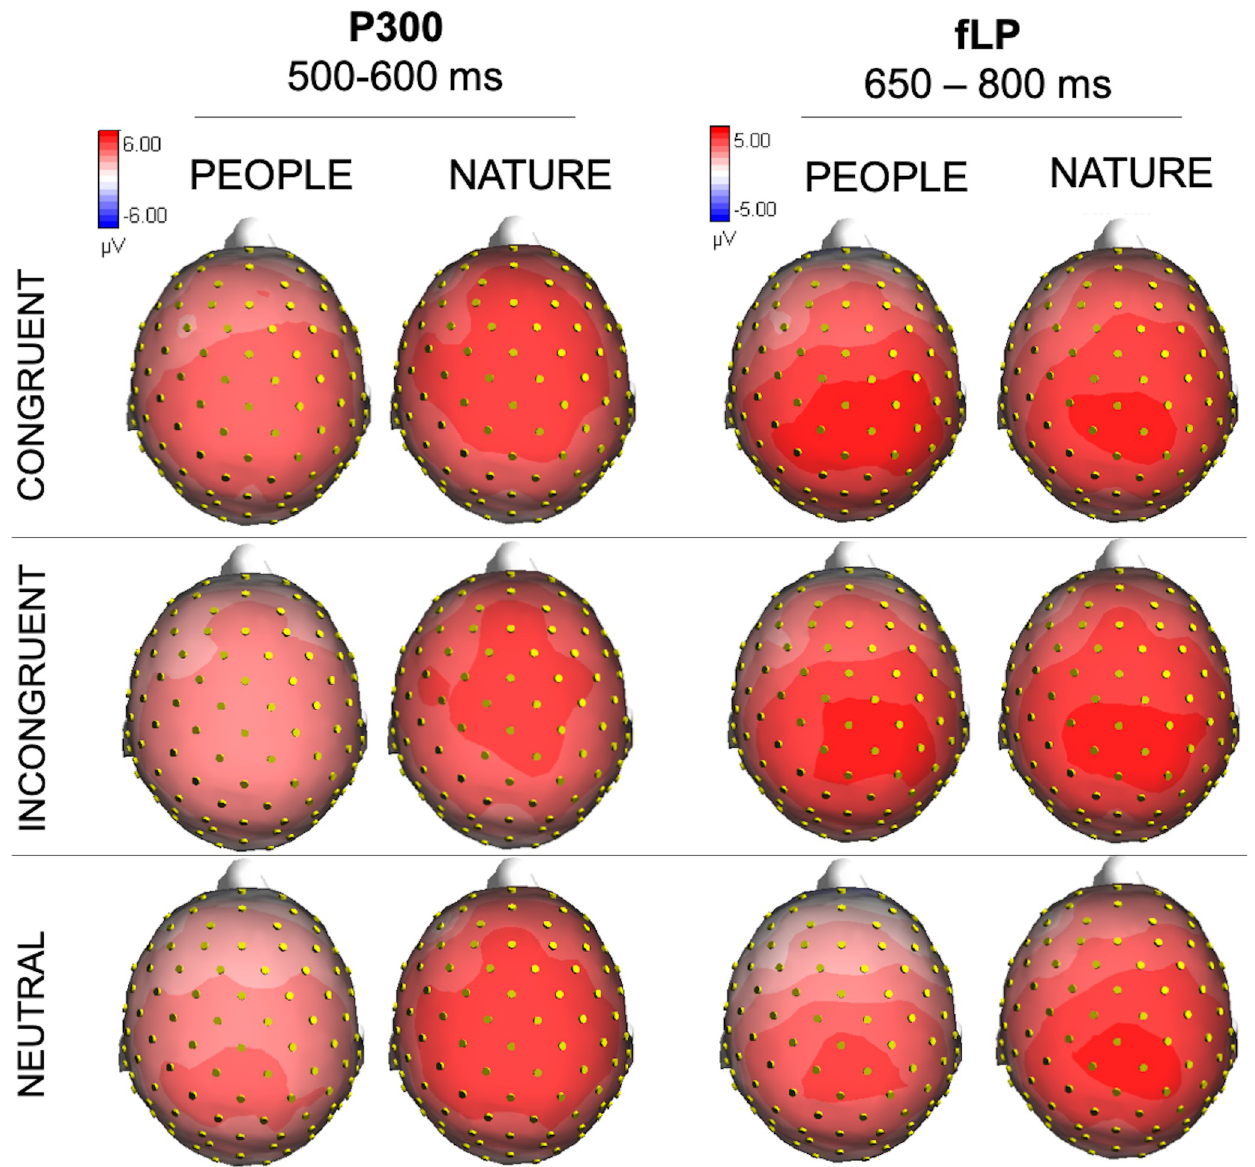
Fig 5. P300 and fLP topographical maps. Isocolor topographical maps of the voltage distribution (top view) of brain potentials in the time windows corresponding to the P300 (500–600 ms) and frontal late positivity (fLP; 650–800